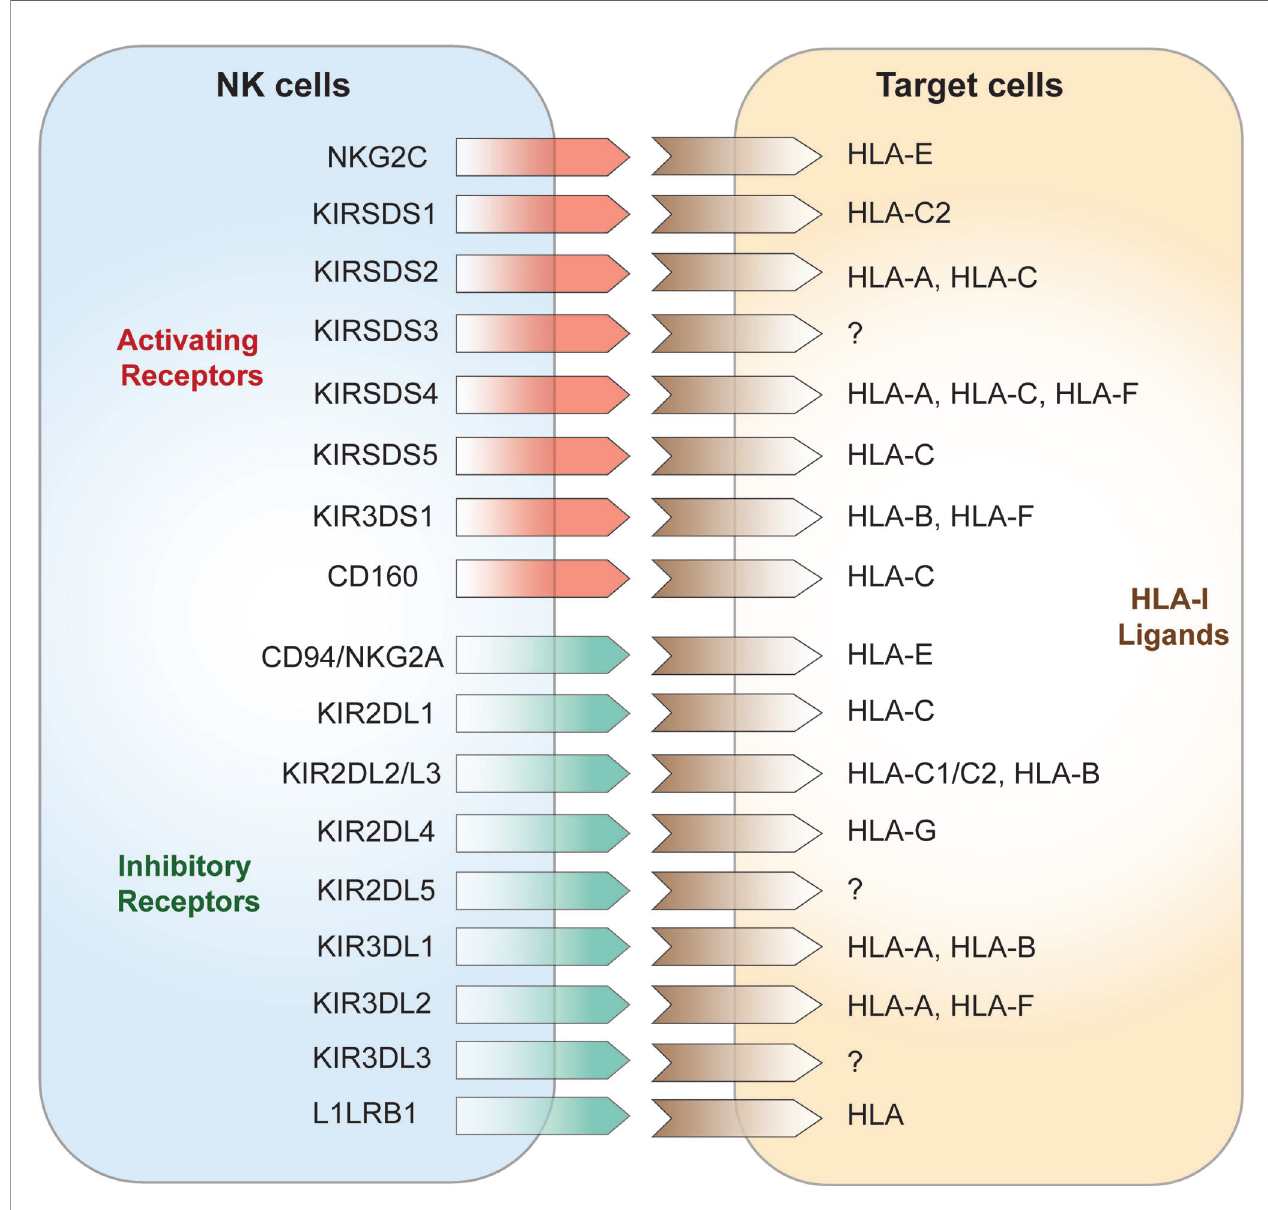
FIGURE 1 | NK cell receptors and HLA class I ligands on target